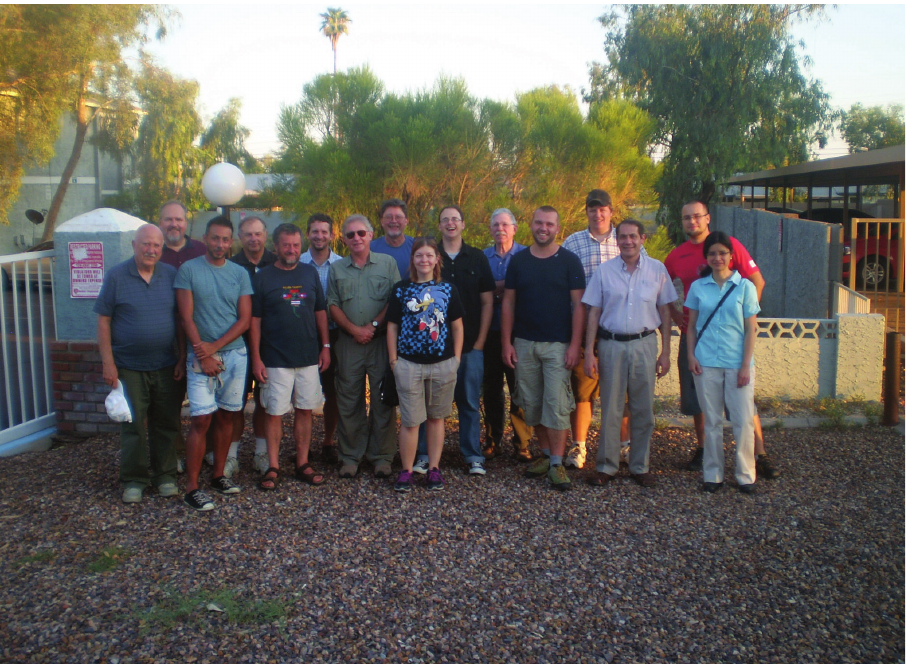
Figure 5. Post meeting dinner. Left to right, back row: Bill Warner, Rich Cunningham, Pat Bouchard, Wolfgang Schawaller, Aaron Smith, Milton Campbell, Andrew Johnston, Marcin Kamiński; front row: Ron Somerby, Gael Kergoat, Roland Grimm, Rolf Aalbu, Rebecca Dornburg, René Fouquè, Gustavo Flores, Paulina Cifuentes